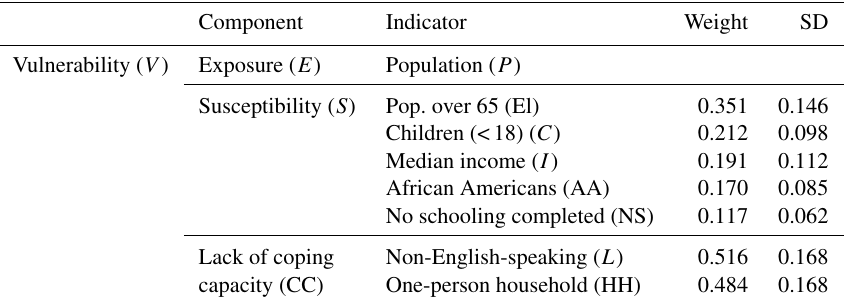
Table 2. Vulnerability indicators and weights derived from the survey with standard deviations (SDs). (Note that the SDs for the two indicators of the lack of coping capacity are equal due to the weighting method which required the allocation of 100 points amongst the sub-indicators’